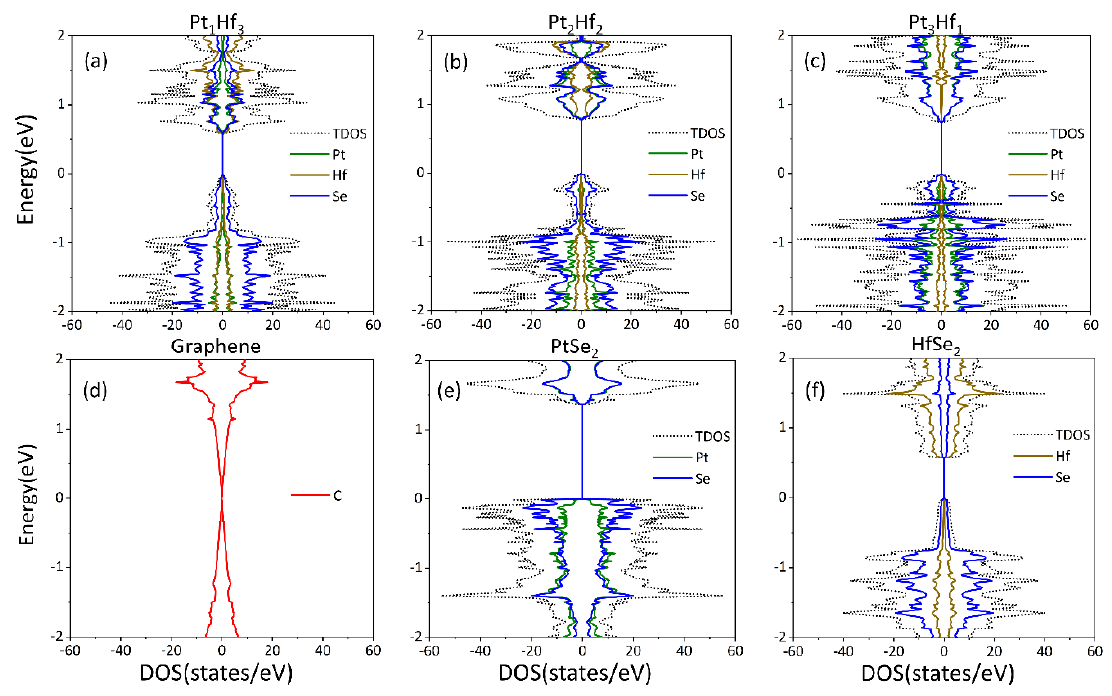
Figure 4. Calculated DOS and PDOS for ( a ) Pt 1 Hf 3 , ( b ) Pt 2 Hf 2 , ( c ) Pt 3 Hf 1 , ( d ) Graphene, ( e ) PtSe 2 , and ( f ) HfSe 2 , where an energy level of zero is scaled to the Fermi level.